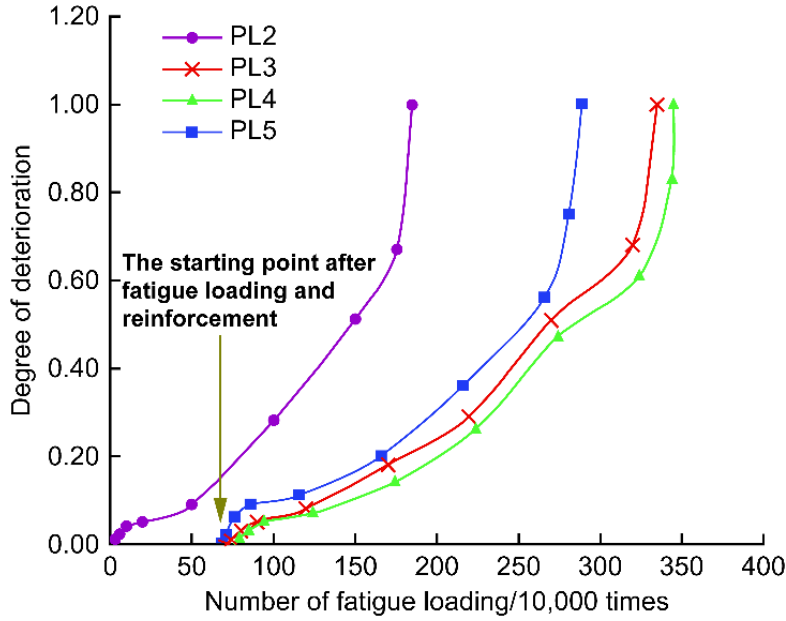
Figure 16. Comparison of deterioration degree.